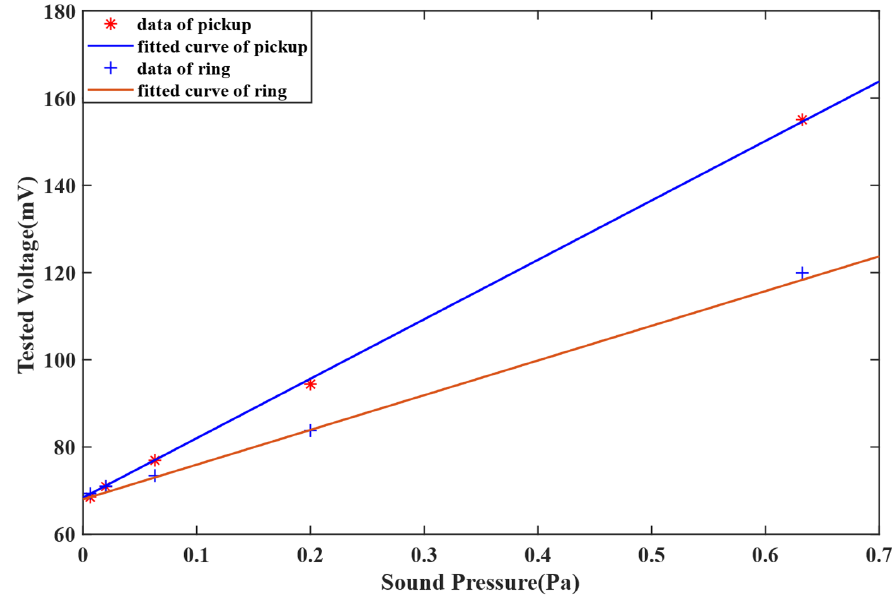
Figure 8. The experimental results of 1000 Hz.